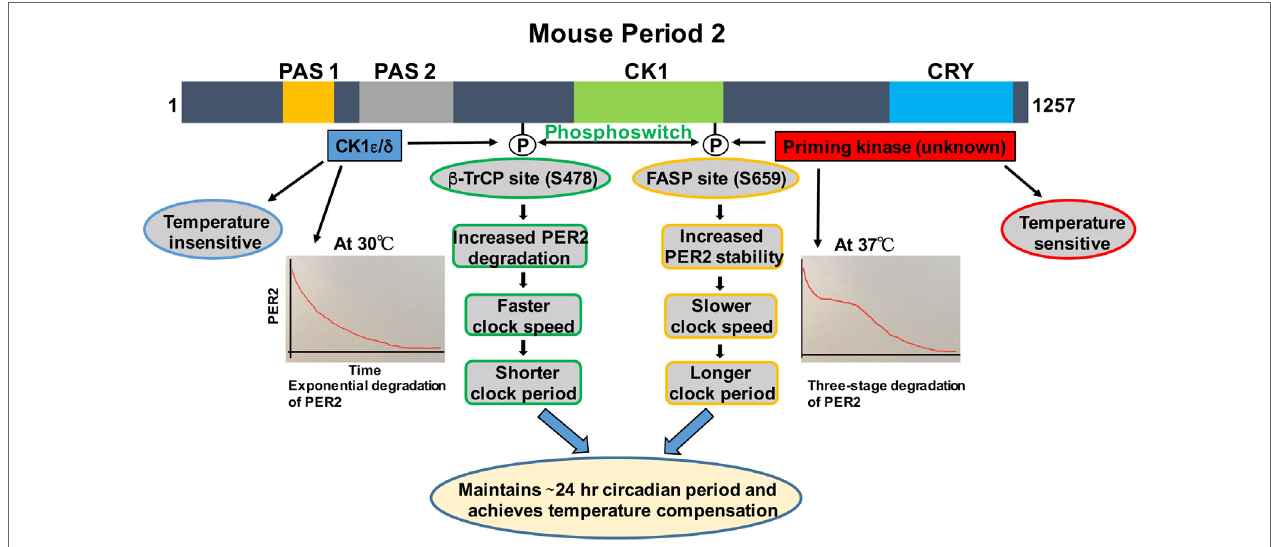
FigURe 1 | Regulation of PeR2 phosphorylation, degradation, and its role in temperature compensation by the phosphoswitch mechanism . Lower temperature increases relative phosphorylation at the β -TrCP site of PER2, leading to faster degradation and shorter period. Higher temperature increases relative familial advanced sleep phase (FASP) site phosphorylation, enhancing PER2 stability and lengthening the period. The degradation pattern of PER2 at 30°C is largely exponential, while at 37°C, three-phase degradation is seen. This has important implications for temperature compensation (see text for details). Domain architectures are shown in colors. PAS1, PAS domain 1 (orange); PAS 2, PAS domain 2 (grey); CK1, Casein kinase 1-binding domain (green); CRY, Cry binding site